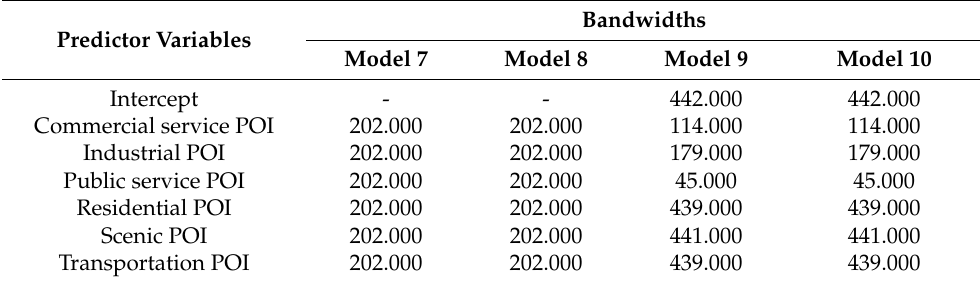
Figure 4. Comparison of the bandwidths of the geographically weighted regression (GWR) and multi-scale geographically weighted regression (MGWR) models. ( a ) The bandwidths of model7 and model8; ( b ) The bandwidths of model9 and model10. Table 5. Multi-scale bandwidth comparison of the GWR and MGWR